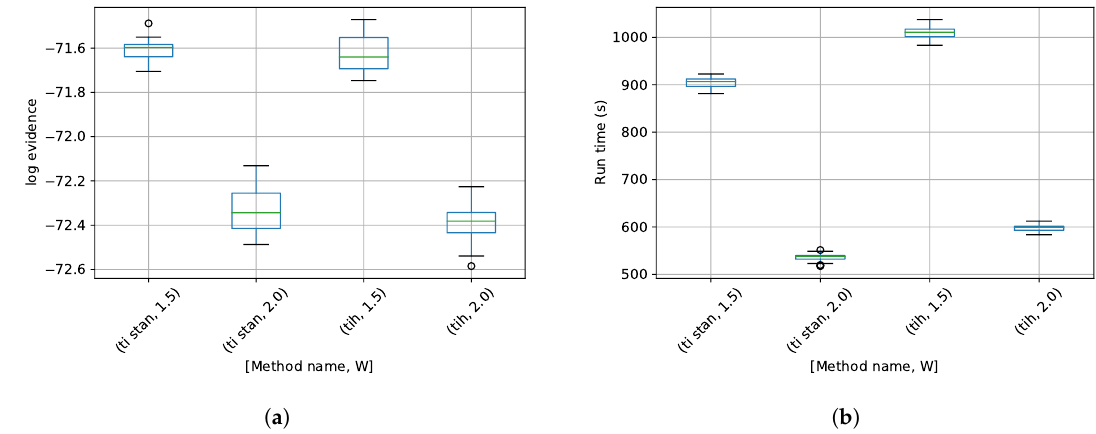
Figure 3. MSF model with J = 2 results. ( a ) Box-plot of log-evidence for the two stationary frequency model for TI-Stan and TI-BSS-H, for two values of W ; ( b ) Box-plot of run time for the two stationary frequency model for TI-Stan and TI-BSS-H, for two values of W